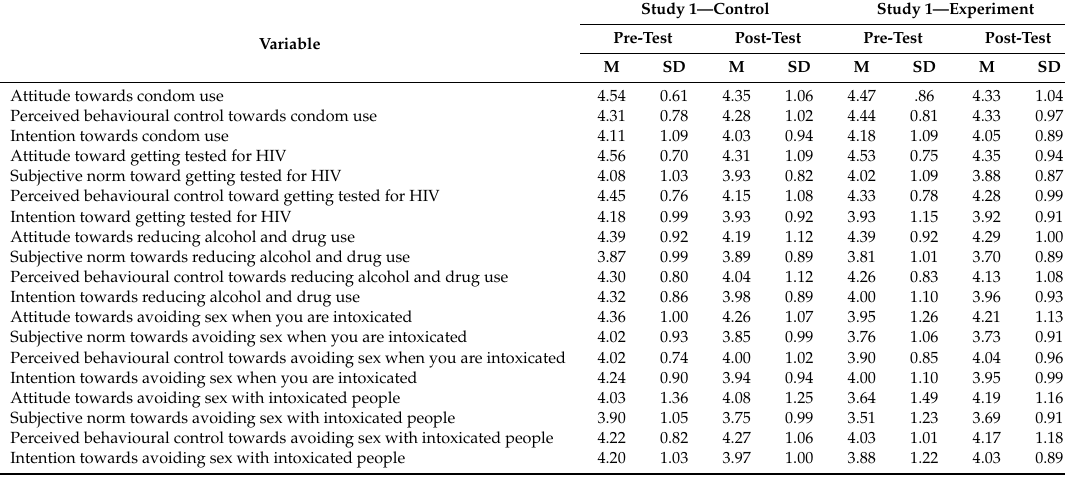
Table 2. Mean scores (M) and standard deviations (SD) for the two groups in Study 1, experiment ( n = 236) and control ( n = 192) at pre-and